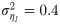
Hierarchical network regime III winner-take-all operation increases offer separability.(A) Example offer where Regime III improves in relative performance as uncertainty increases. (B) Linear and max operations used to calculate decision value distributions for the offer shown in (A). In a linear operation, the mean and variance of both attribute are used to calculate distribution from which the final offer value is drawn. The max operation first selects the larger within-attribute alternative, which then becomes the decision value distribution. (C) Decision value distributions produced by the max operation maintain greater separability as uncertainty increases. Distributions are shown for the decision values calculated in (B) using σηI2=0.4 (top row), σηI2=0.75 (middle row) and σηI2=1.5 (bottom row). In the left column are results for the linear operation, and in the right from the max operation. (D) For those offers where regime III performance (J+ = 0.35, J− = −0.1) exceeds that of the LN, a max operation provides greater separability between decision value distributions. For offers that transitioned to better HN performance, at each uncertainty level we calculated the d′ of decision value distributions produced by the linear operation and the max operation. Shown are the mean and standard error of the d′s.